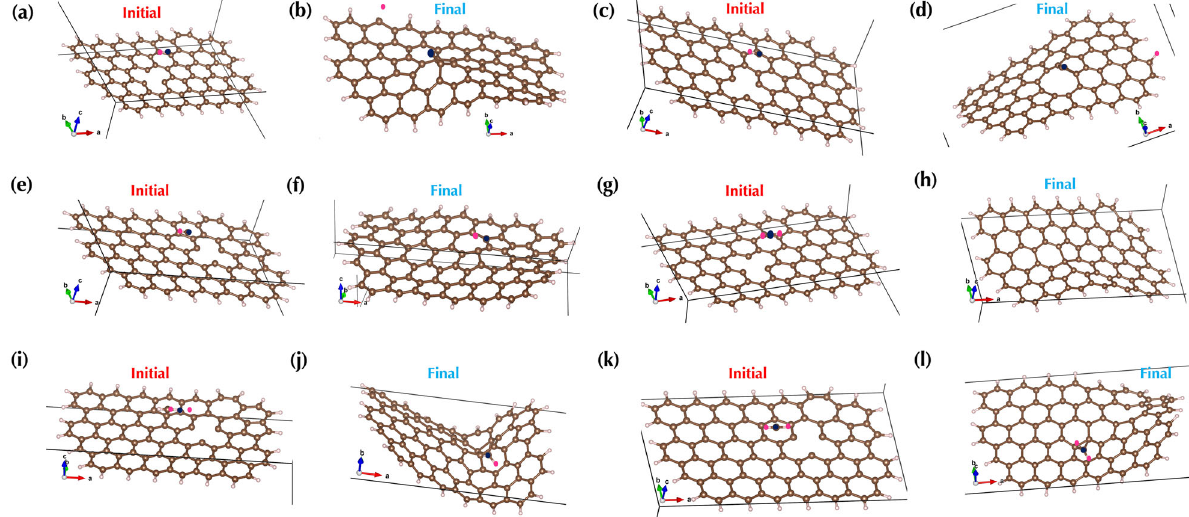
Fig. 6 Snapshots from AIMD simulations with CH and CH2 ad-atoms performed at 300 K. Initial con fi gurations ( a , c , e , g , i , k ) and fi nal states ( b , d , f , h , j , l ) where CH and CH 2 groups (marked with blue and pink) are added to graphene systems are shown in the fi